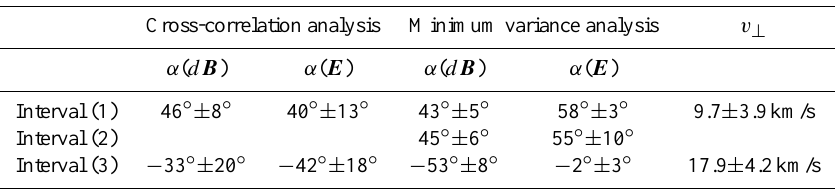
Table 2. Summary of results from cross correlation and minimum variance